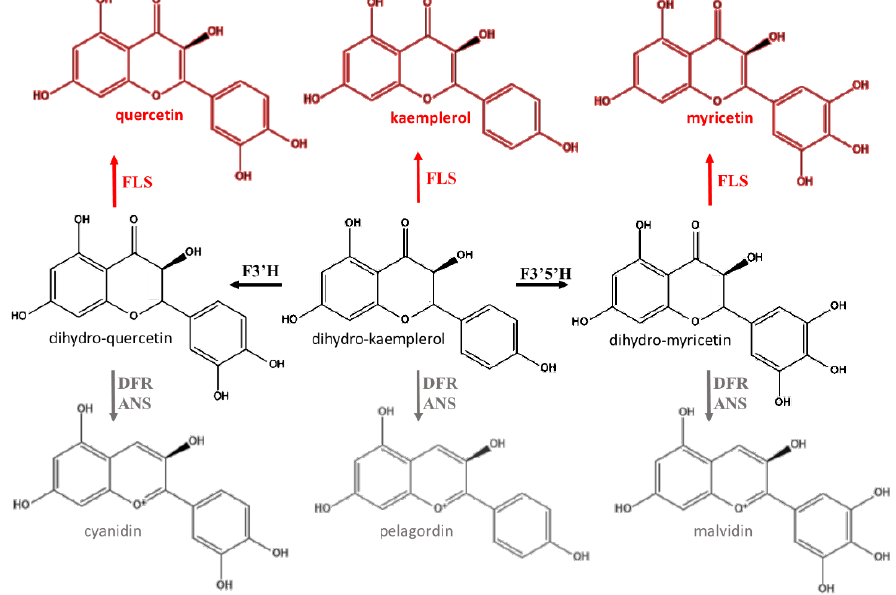
Figure 3. Alternative biochemical pathway to anthocyanin synthesis. FLS: flavonoid synthase; F 3′ H: fl avonoid 3′ -hydroxylase; F 3′5′H: flavonoid 3′,5′ -hydroxylase; DFR: dihydroflavonol reductase; ANS: anthocyanidin synthase (ANS).